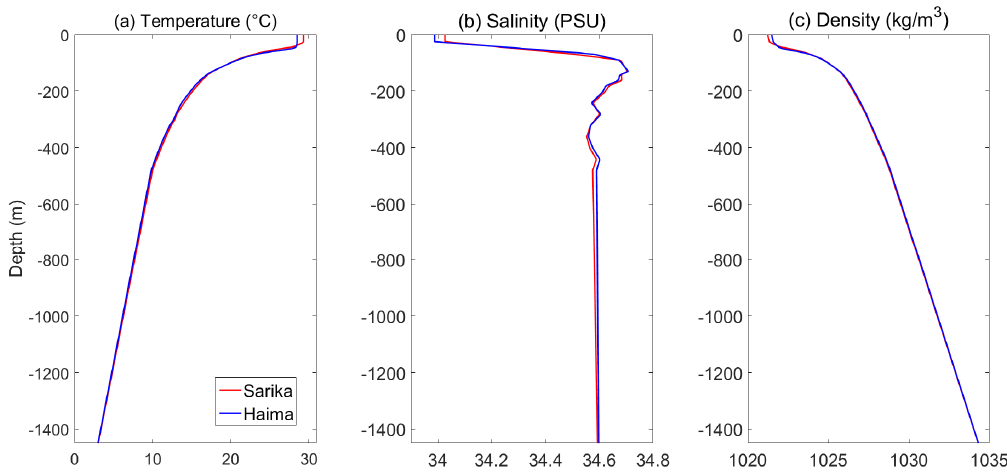
Figure 2. Initial temperature, salinity, and density profiles for Sarika (red) and Haima (blue) in 3DPWP model simulation. Profiles for Sarika (Haima) are averaged over UTC 00:00 on 14 (16) October to UTC 00:00 on 16 (20) October of the observation at Station 2. 3DPWP: three-dimensional version of the Price–Weller–Pinkel